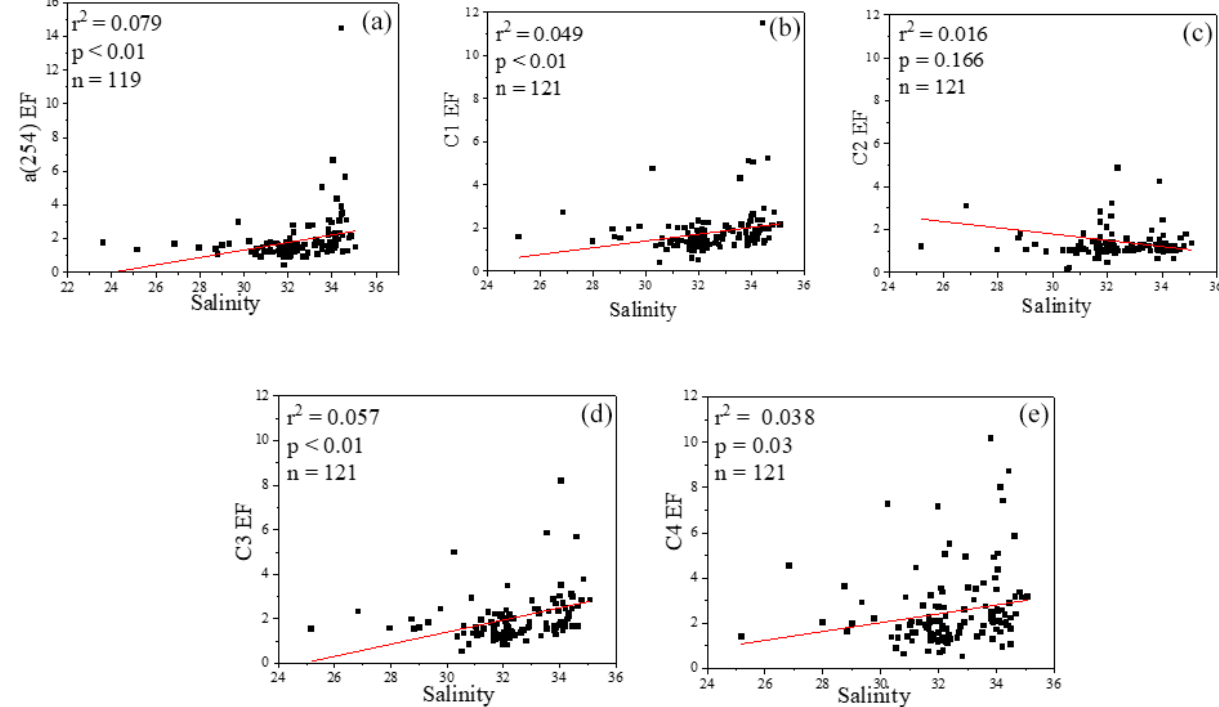
Figure 8. Relationships between salinity and EFs of a (254), Chl a , DOC and four fluorescence